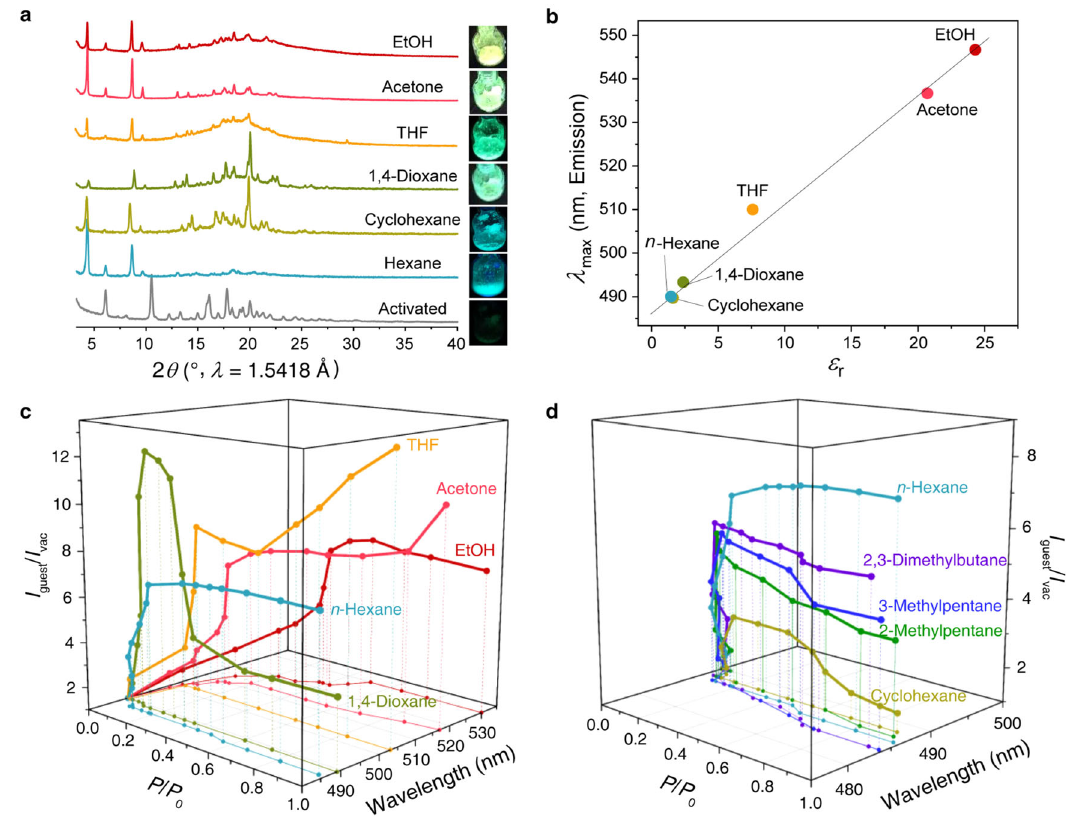
Fig. 5 | Molecular sensing is endowed by the universality of adaptive guest inclusion of dynaCOF-330. a Fluorescence responses upon adaptive inclusion of various saturated organic vapours indicated by the changes of PXRD patterns. b Guestpolarity( ε r ,dielectricconstantat25°C)dependenceofemissionmaximum